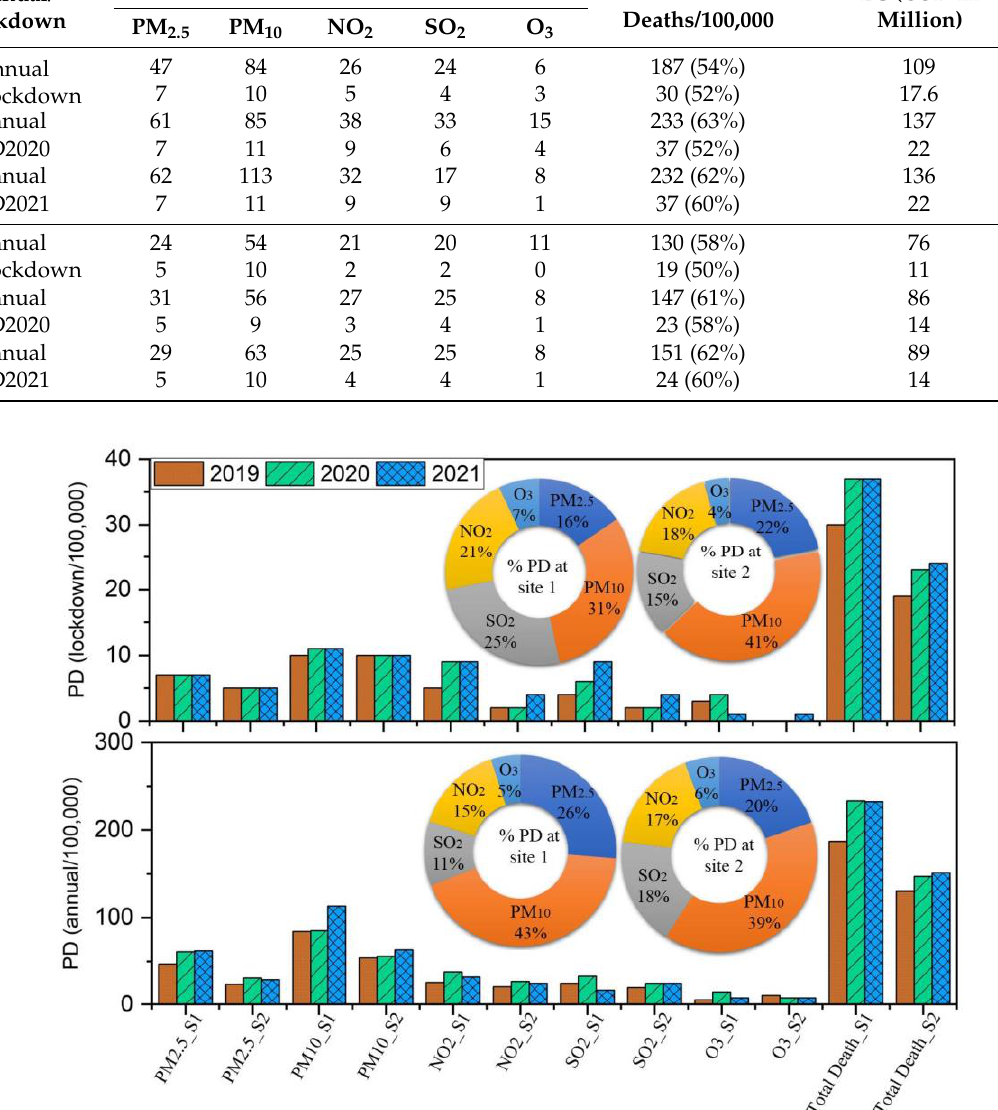
Figure 7. Pollutant-wise annual and lockdown period premature death (PD) attribution at site #1 and site #2.